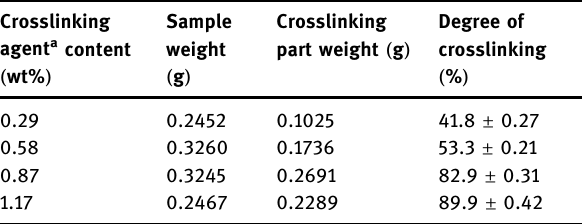
Table 2: E ff ect of crosslinking agent content on crosslinking degree of microspheres